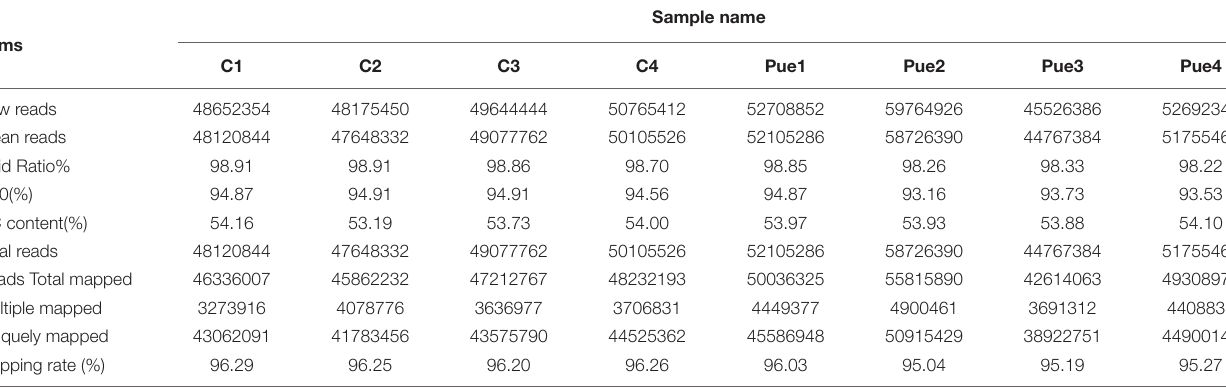
FIGURE 1 | Effect of Puerarin on the activity of fat metabolizing enzymes in heat stressed beef cattle ( n = 4). Control: dietary supplementation with 0 mg/kg Puerarin in the feed concentrate; Pue400: dietary supplementation with 400 mg/kg Puerarin in the feed concentrate; Pue800: dietary supplementation with 800 mg/kg Puerarin in the feed concentrate. HSL, hormone sensitive lipase (A) ; LPL, lipoprotein lipase (B) ; ACC, acetyl CoA carboxylase (C) ; FAS, fatty acid synthase (D) . a , b Means within a row with no common superscript differ significantly ( P < 0.05). TABLE 6 | Summary statistics for sequence quality and alignment information of eight longissimus thoracis muscle samples in two